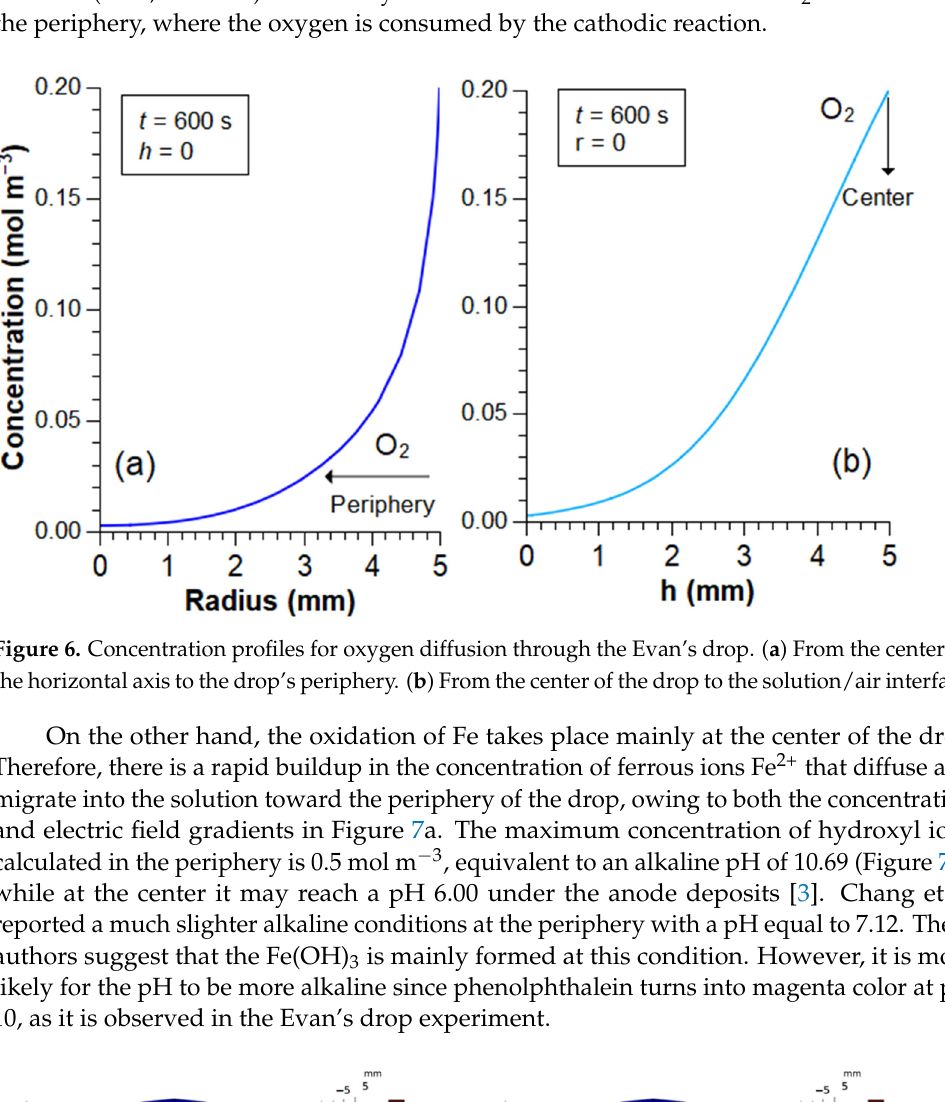
Figure 8. Variation of the ferrous ion concentration with time at a point in the center of the drop’s base (orange line); and the variation of OH − ion concentration with time located in the drop’s pe- riphery represented by the upper, blue line. The complete group of species produced in the Evans’s drop is summarized in Figure 9. Figure 9a shows the concentration profile of Fe(OH) 2 . Since the highest OH - concentra- tion is at the periphery and Fe 2+ can travel by diffusion and migration, the highest concen- tration of Fe(OH) 2 appears near to the drop edges [14]. When the Fe 2+ ions come in contact with the dissolved oxygen at the periphery, they oxidize to ferric ions, Fe 3+ . In a similar process, ferric ions, Fe 3+ , react with hydroxyl ions in solution and form ferric hydroxide, or as a result of the oxidation of Fe(OH) 2 in the presence of O 2 as shown in Figure 9b. The formation of ferric ions takes place to a lesser degree, due to the scarcity of Fe 3+ in solution as it is observed in Figure 9c.